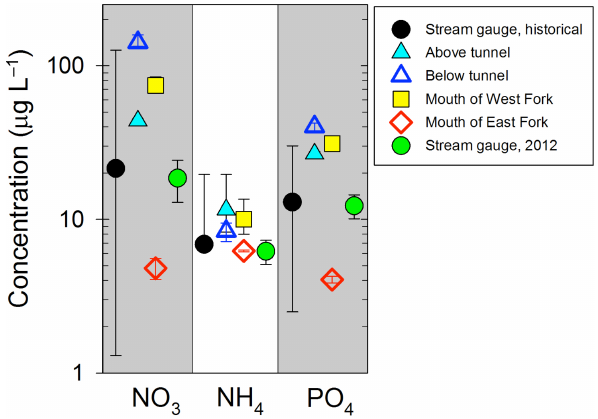
Figure 5. Mean (symbols) and ranges of concentrations of electrical conductivity ( n >5000) and major nutrients ( n = 47) for historical data collected over 15years at the stream gauge, at the stream gauge in 2012 (i.e., after permafrost degradation in banks; n = 2), stream water just above a 20m thermokarst tunnel ( n = 5), stream water just below a 20m thermokarst tunnel ( n = 5), in the West Fork ( n = 6) and in the East Fork ( n = 2), just above the location where the West and East Forks mix. Electrical conductivity is plotted with the scale on the left y axis, while nitrate, ammonium, and phosphate concentrations are indicated on the right y axis (log-scale). Refer to figure 3C for sampling locations. Concentration are in micrograms per liter of N or